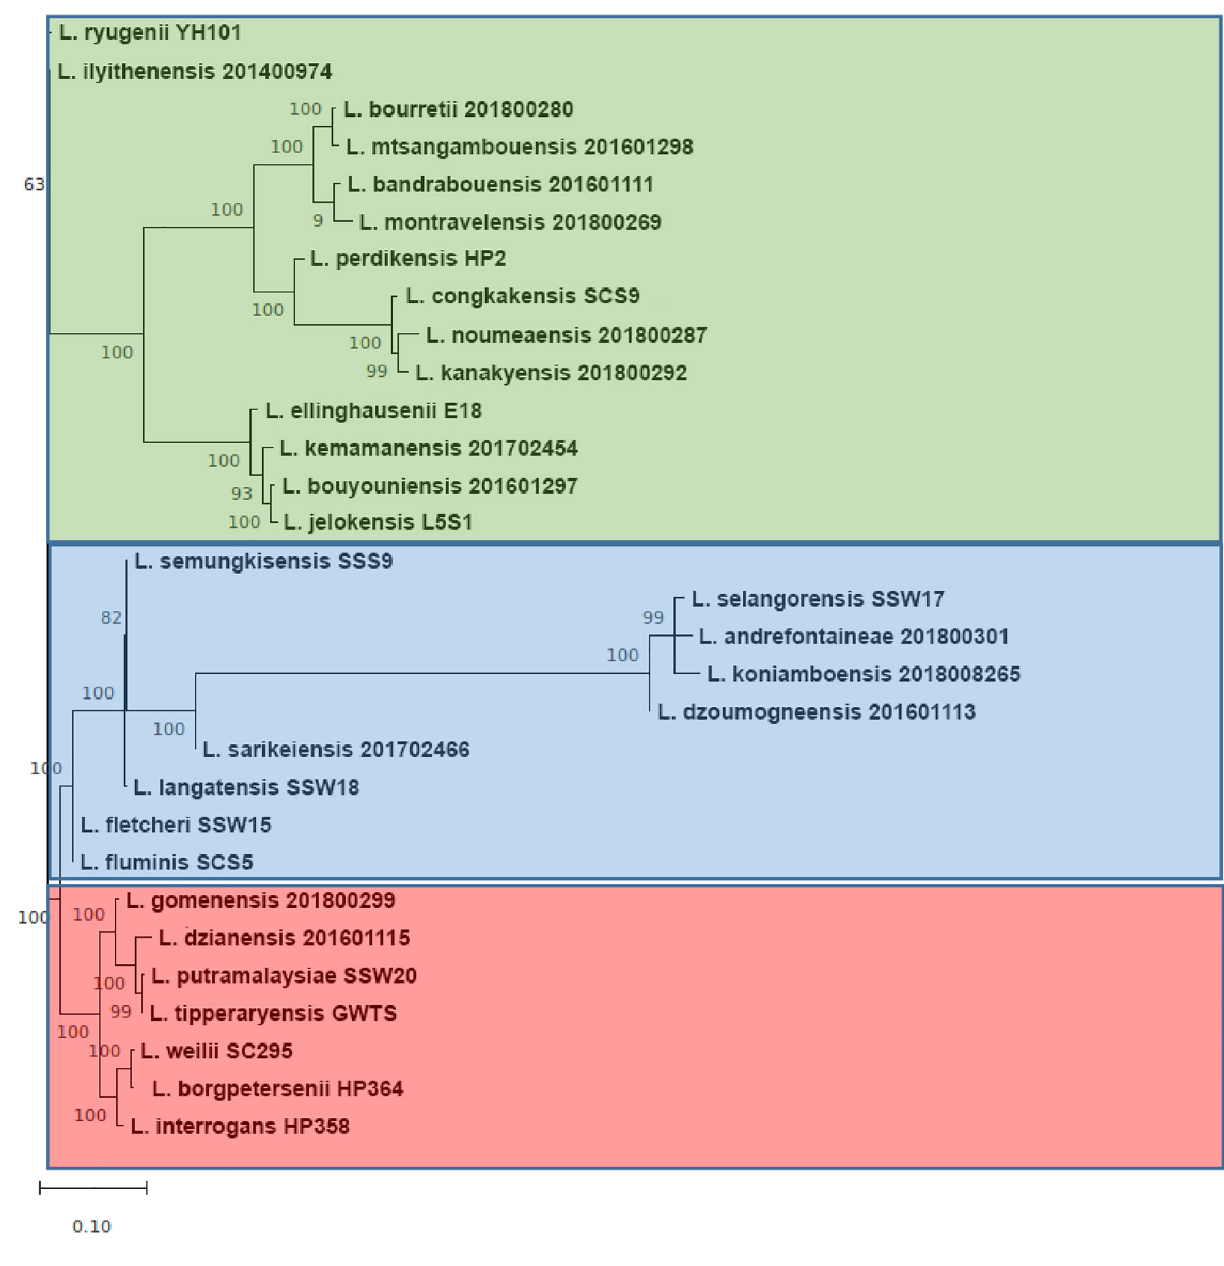
FIGURE 6 | The core-genome phylogenetic tree. The group colored red, blue, and green corresponding to pathogenic, intermediate, and non-pathogenic clades, respectively. Each major branch of tree was supported with very high bootstrap